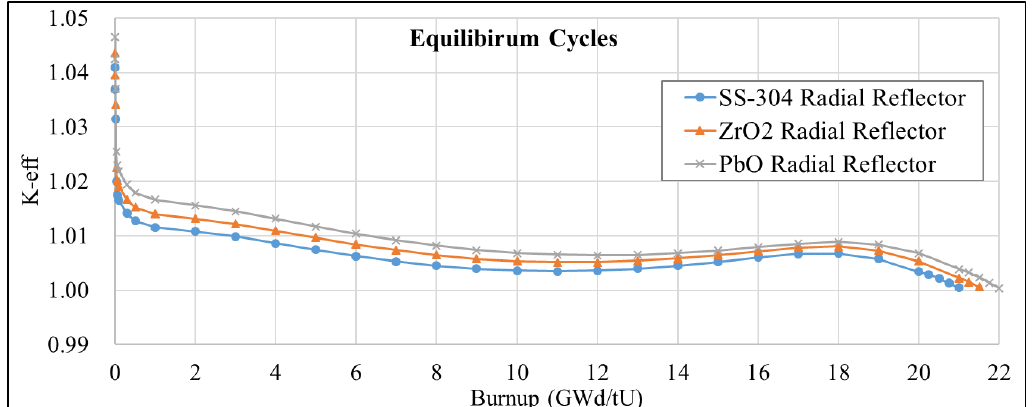
Figure 4: Multiplication Factor Evolution of the Two-batch ATOM Cores with Various Reflectors